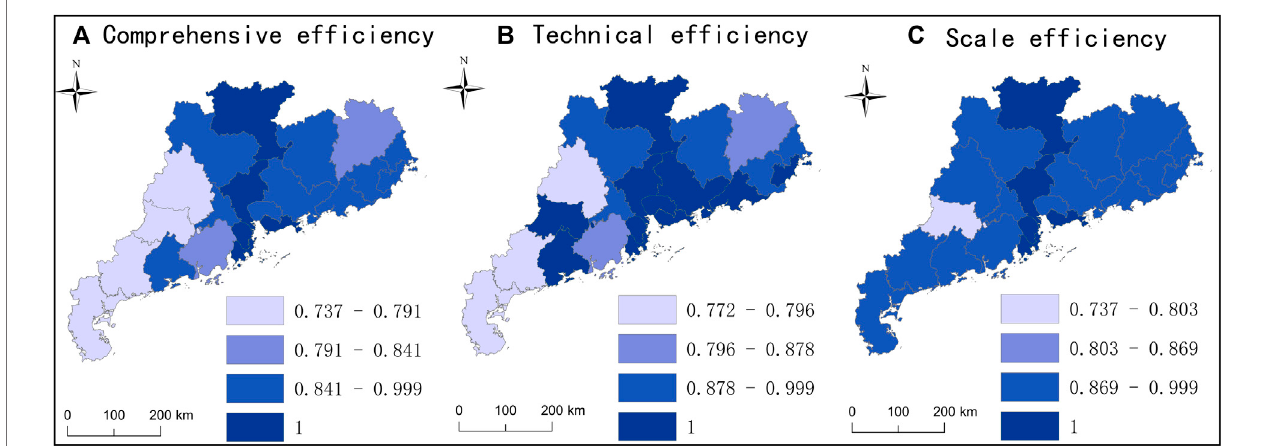
FIGURE 4 | WUE of the prefecture-level cities in Guangdong Province in 2012 –